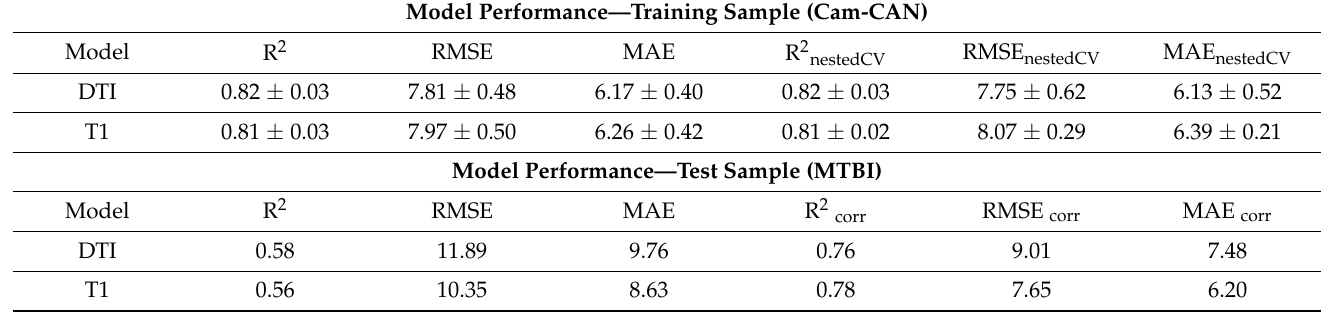
Table 3. Brain age prediction.